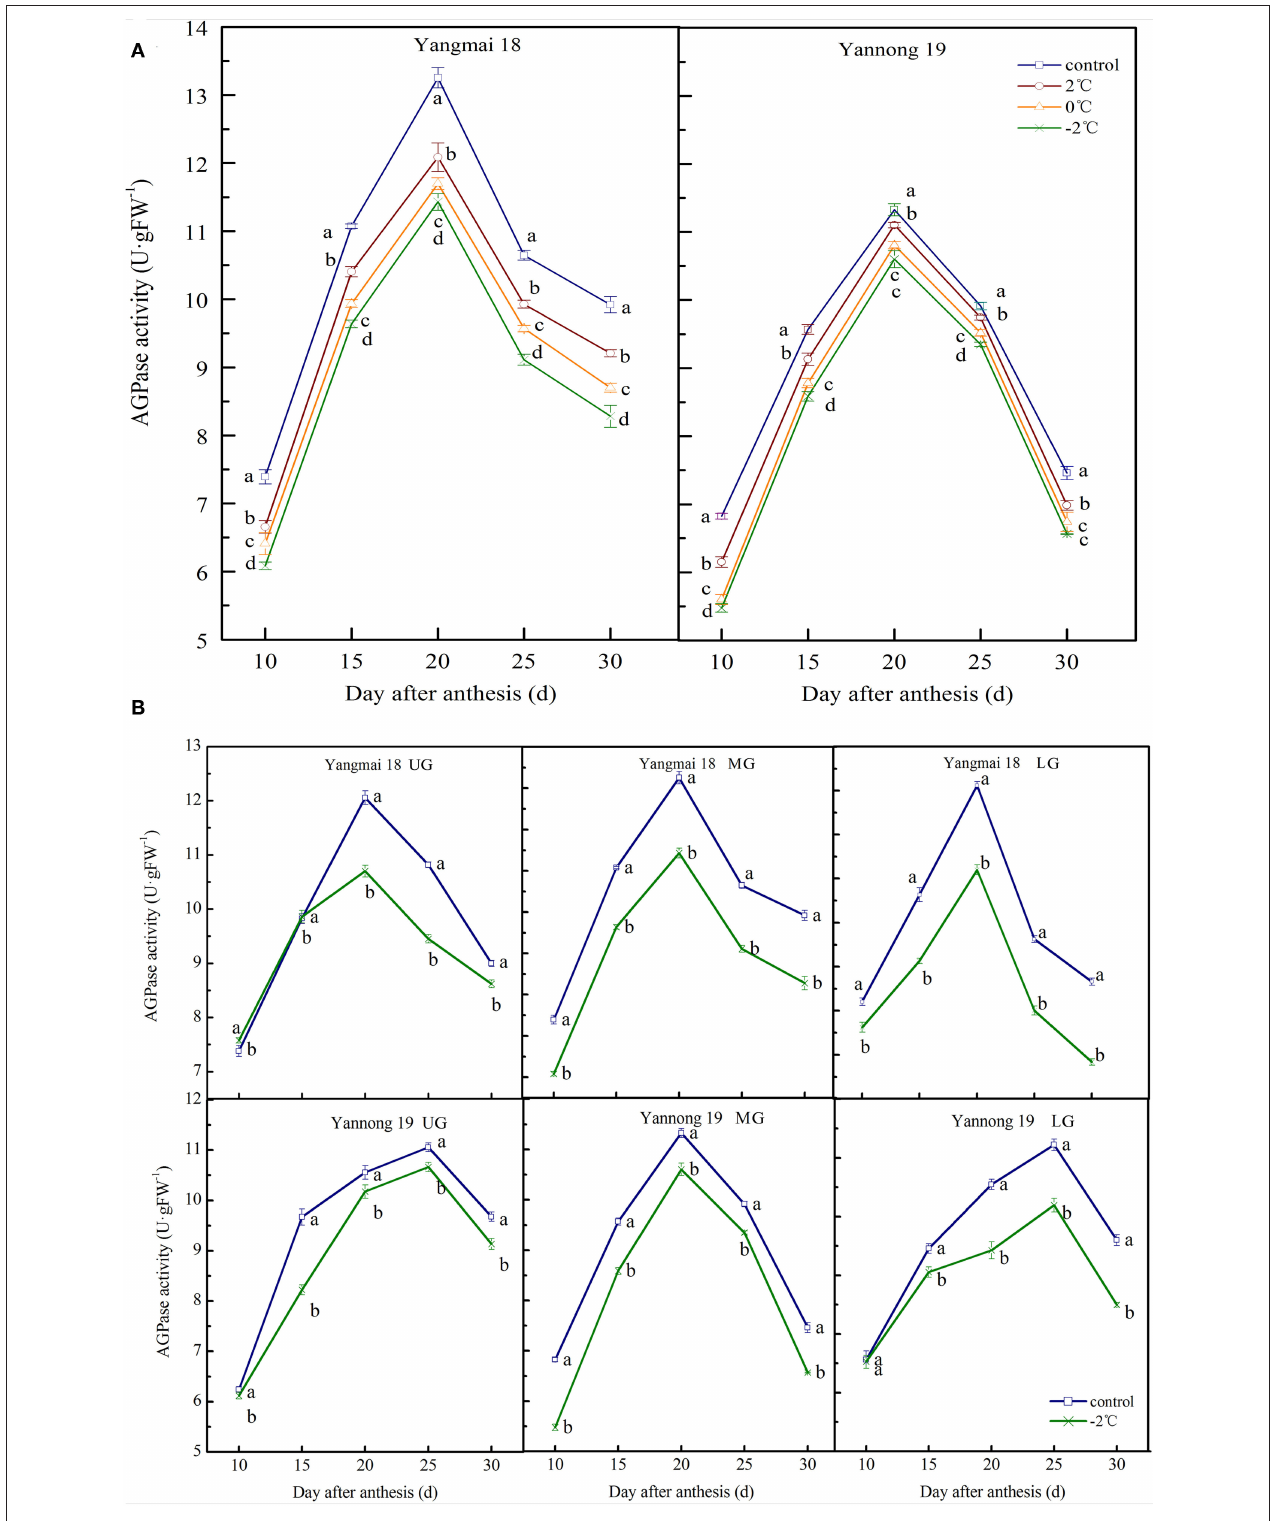
FIGURE 3 | The effect of short-term LT at the booting stage on the ADP-glucose pyrophosphorylase activity of wheat grains in the middle spikelets (A) and at different positions of the spikelets (B) . UG, grains in the upper spikelets; MG, grains in the middle spikelets; LG, grains in lower spikelets. At booting stage, wheat plants